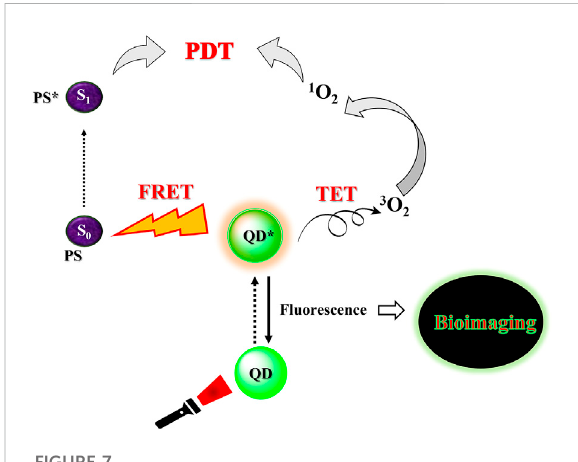
FIGURE 7 Simplistic representation of the applicability of quantum dots as photosensitizers for photodynamic